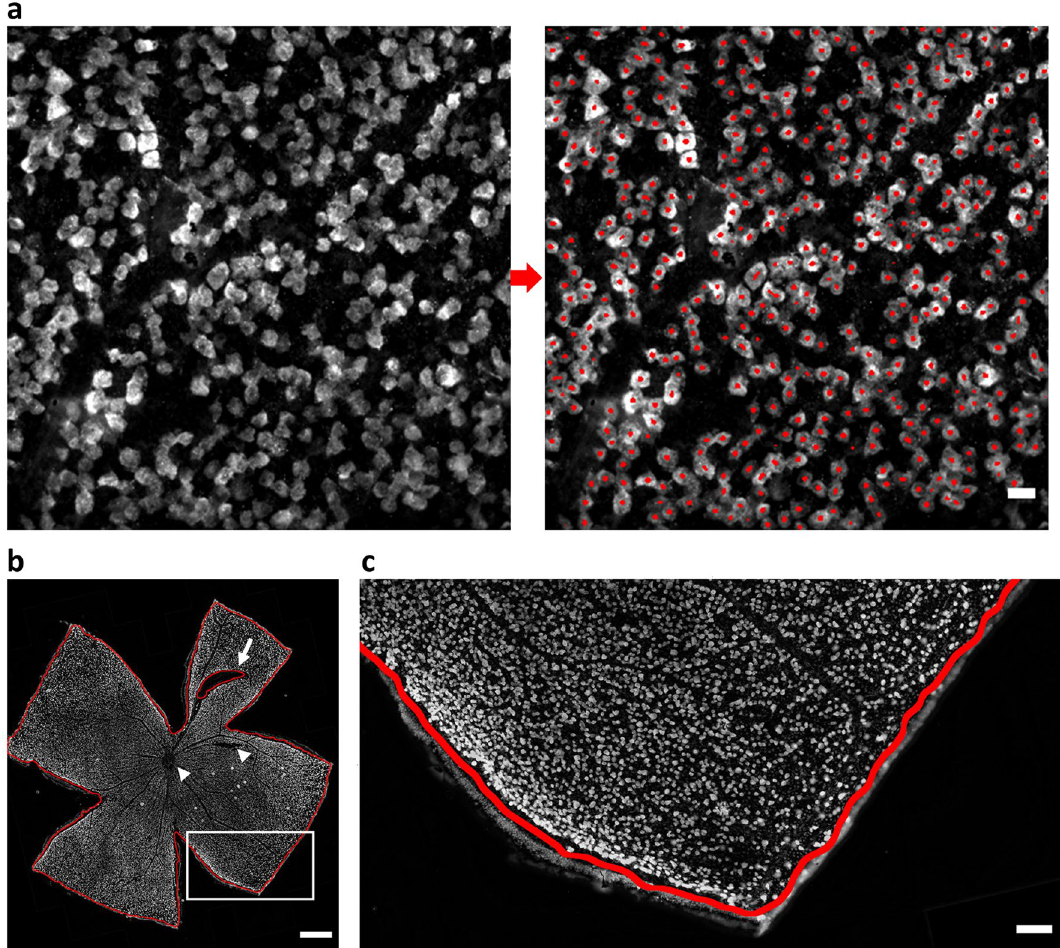
Figure 3. Representative examples of the output of RGCode on testing data. ( a ) Testing frame sampled from the mid-peripheral region of a naive retina, showing the input and output of RGCode. In general, RGCode consistently detects and counts RBPMS+ cells and clearly distinguishes overlapping cells. Scale bar = 20 µ m . ( b , c ) Naive testing retina showing the output of the segmentation model. Scale bars = 500 µ m and 100 µ m